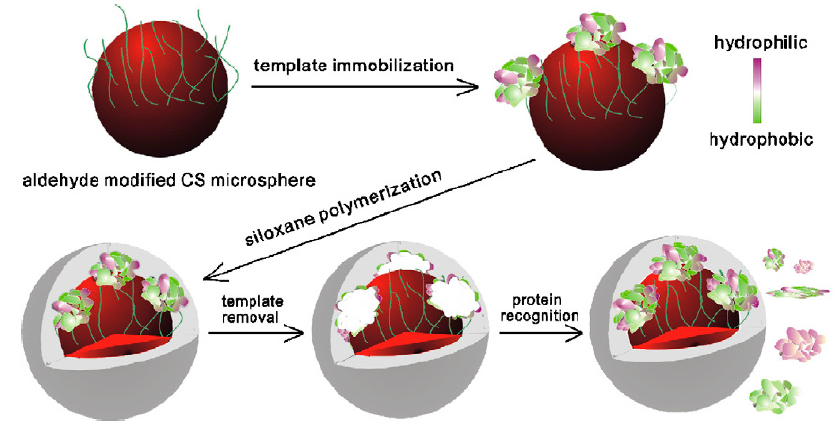
Figure 4. Schematic representation of synthesis of protein imprinted polymers on CS microsphere using immobilized protein as a template. The synthesis involved three steps; Firstly, template BSA was covalently immobilized on the polysaccharide core by forming imine bonds. The second step involved siloxanes polymerization on the polysaccharide–protein surface. It resulted in a polymeric network molded around the template. The template protein was removed in the third step. Cavities complementary to the template protein in shape, size, and functional group orientation were created (reproduced from [56] with permission).